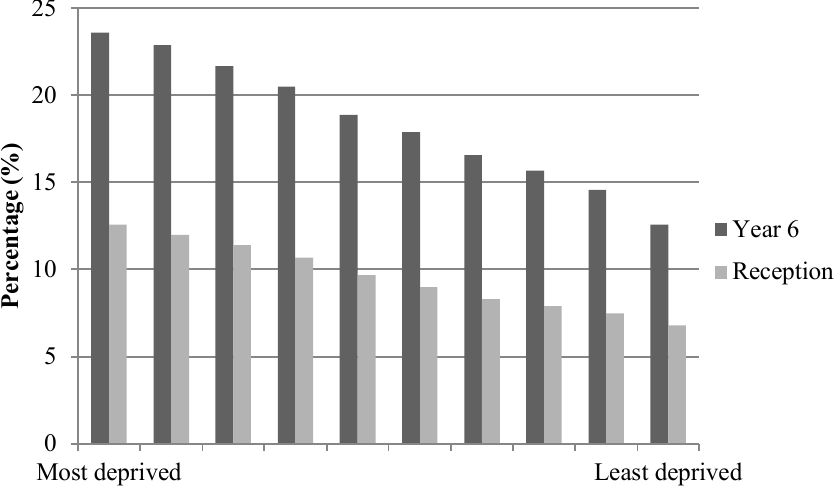
Figure 1. Prevalence of obesity by deprivation decile in English school children, in Reception and Year